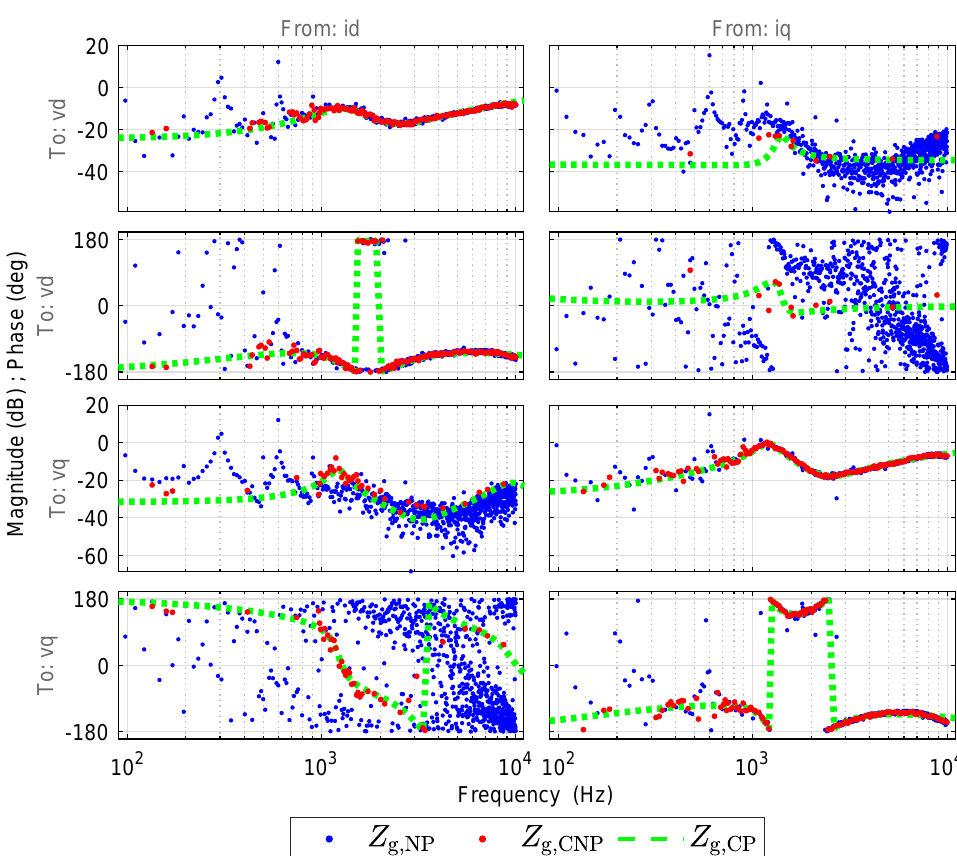
Figure 28. Identification of the parametric impedance of the industrial power